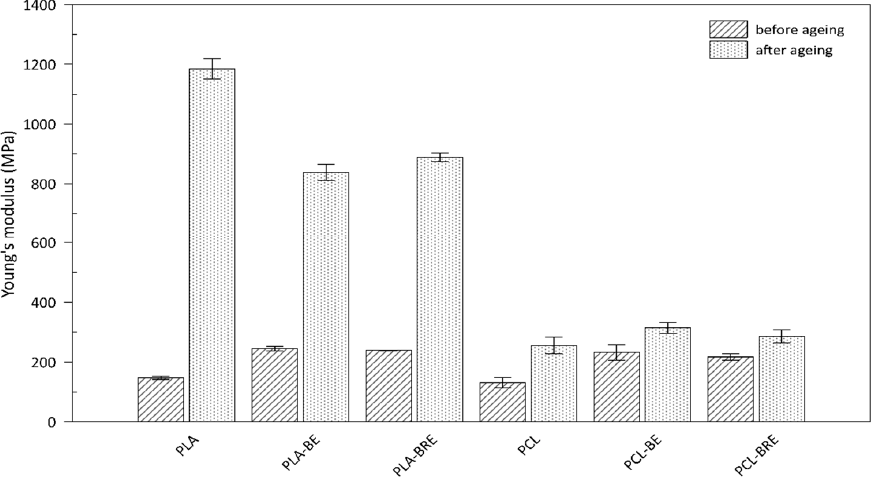
Figure 7. Mechanical properties of the PLA and PCL samples as per Young’s modulus.